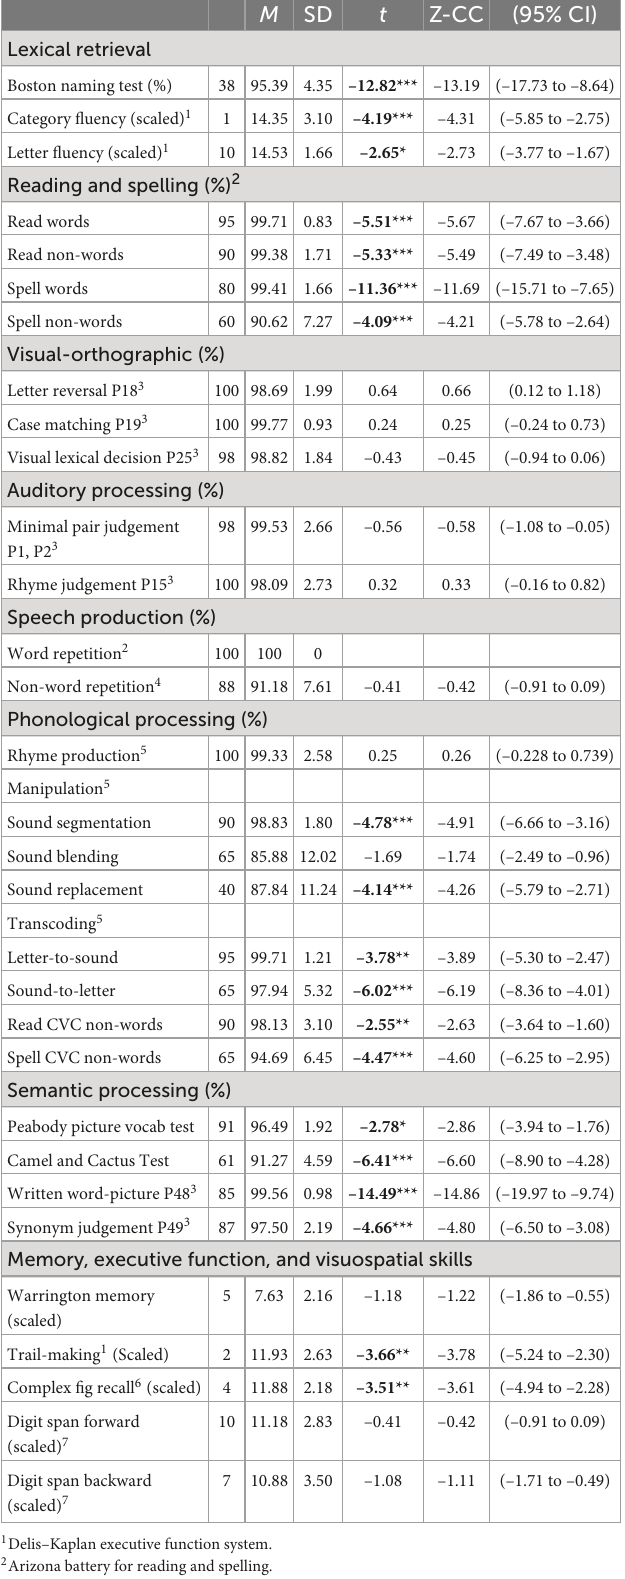
TABLE 1 LV2’s pre-treatment performance with comparison to healthy controls ( n =